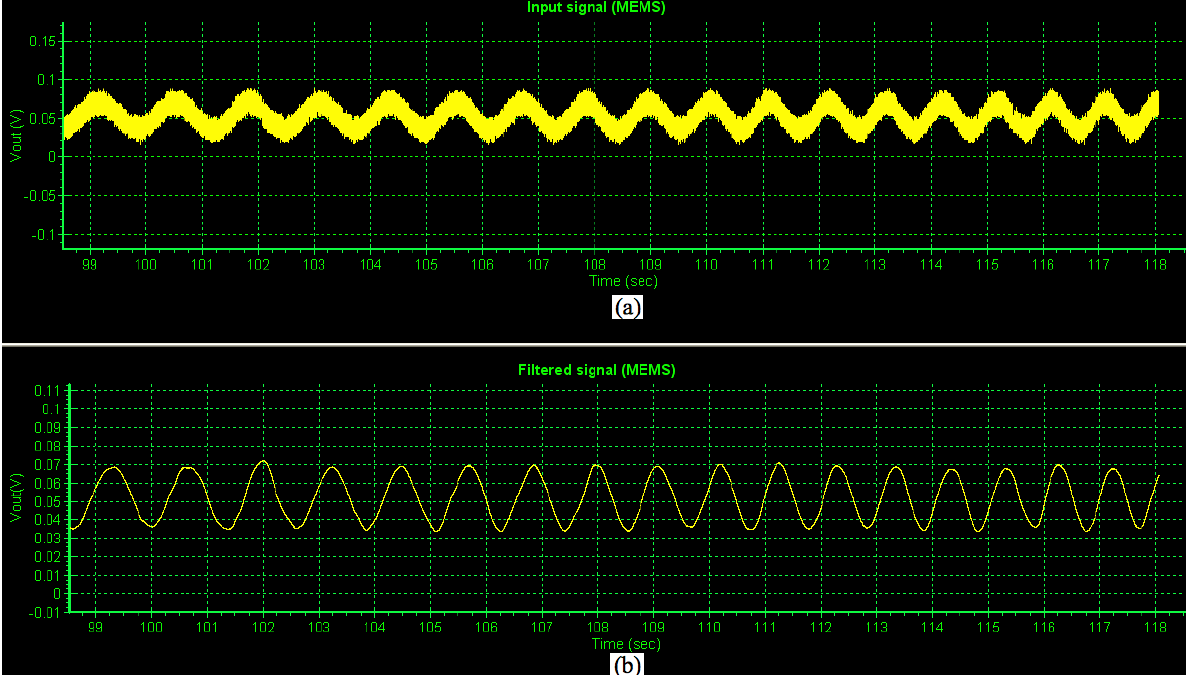
Figure 8. ( a ) Non-filtered and ( b ) filtered PCB output voltage (amplified 5,000 times) of the MEMS sensor generated by an alternating magnetic flux density with a maximum magnitude of 3,300